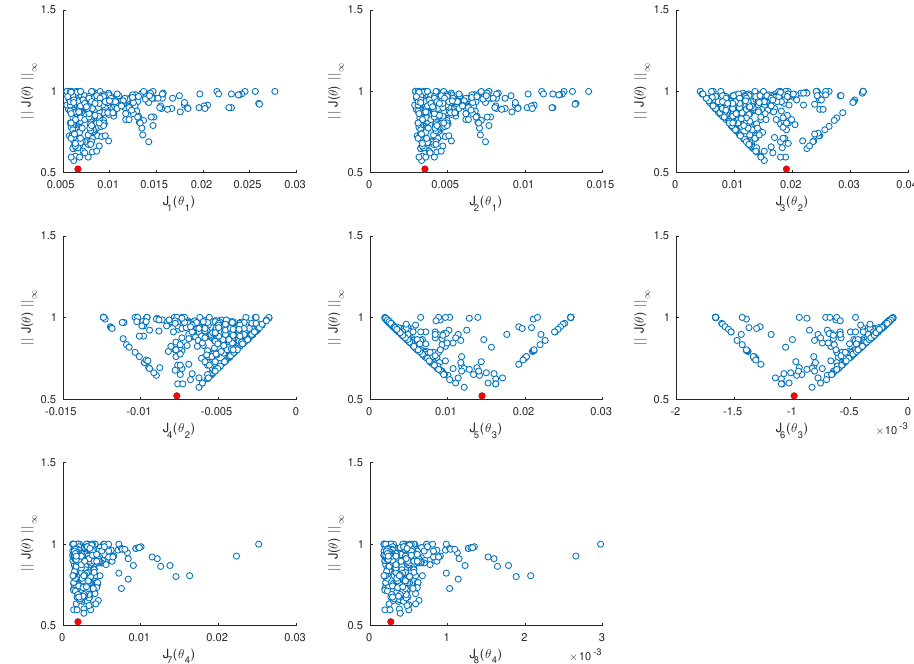
Figure 6. Representation of Pareto front using ∞ − norm . The J pair sub-indices represent the κ values in each S i segment, while the J odd sub-indices represent the τ values in the same S i segments. Targets closest to J ideal are shaded in red circles.